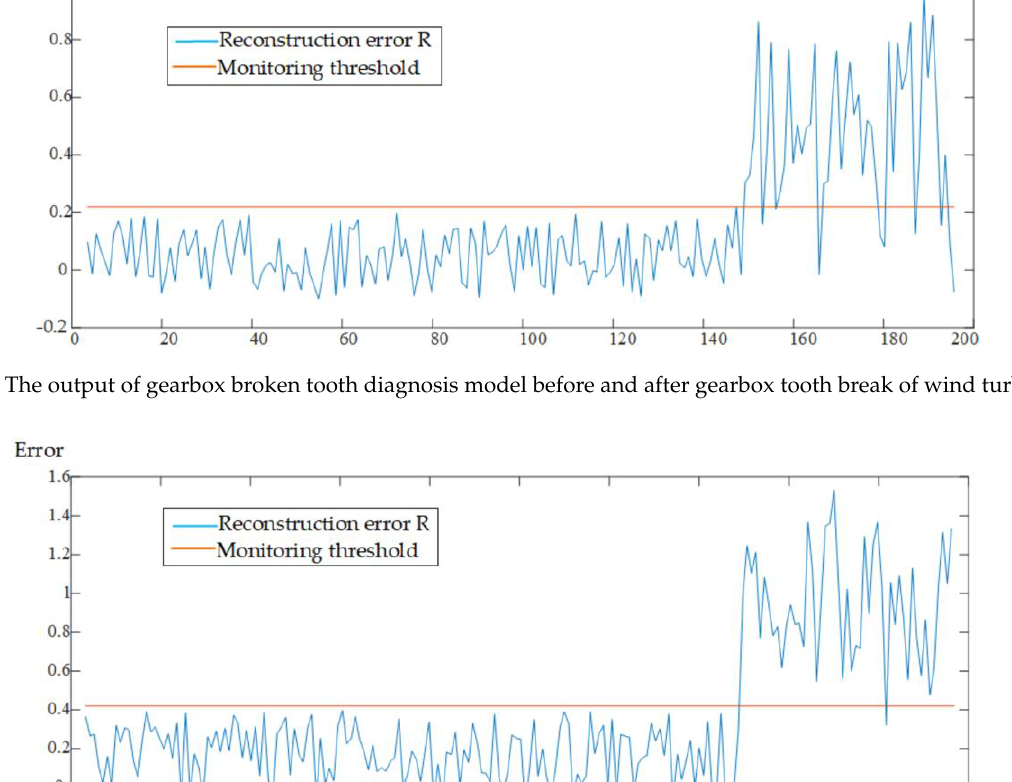
12 of 19 Figure 6. Monitoring platform in operating status. Figure 7. Fault diagnosis module of the monitoring system.